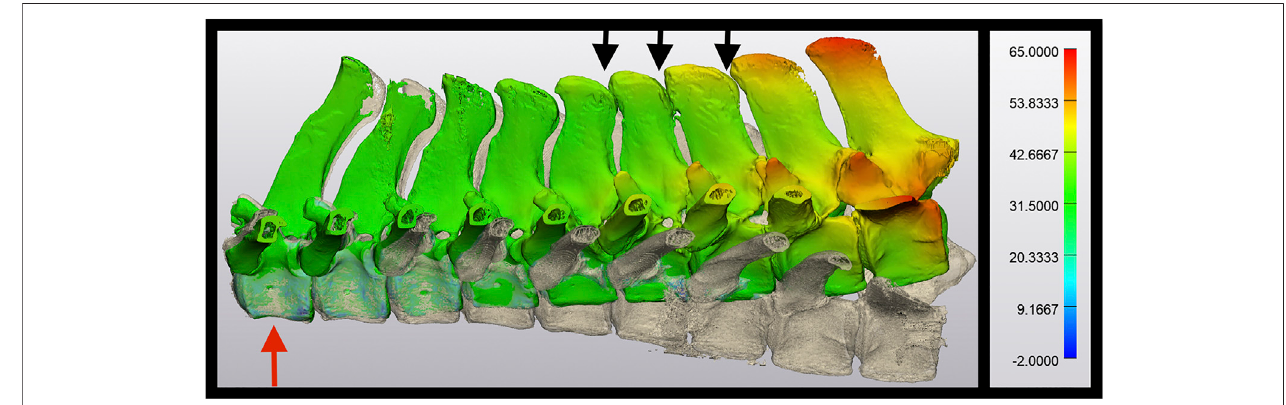
FIGURE 4 | Use of Hausdorff distance to demonstrate dorsoventral excursion. In this image, T11vertebra (red arrow) have been superimposed over each other. Thespinecurvingtowardthetopoftheimagerepresentsaspineinextension,andthespinecurvingtowardthebottomoftheimagerepresentsthesamespinein fl exion. The color overlay represents the translation in mm between the two phases, peaking at 65.0 mm in this post-ISLD section. Note the close proximity of each DSP and narrowing of the interspinous space (black arrows) during the fl exion